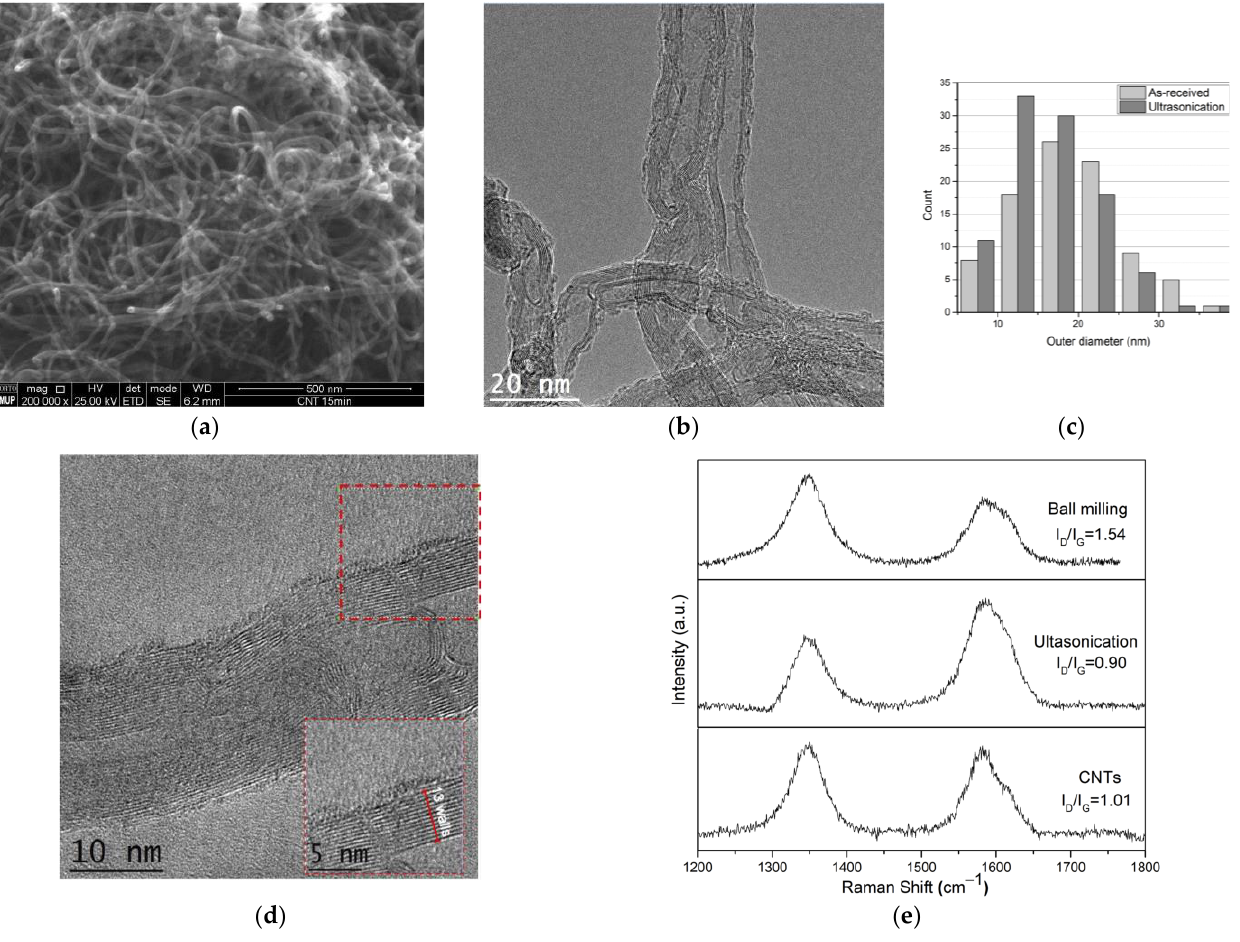
Figure 4. ( a ) SEM and ( b ) TEM images of ultrasonication CNTs, ( c ) distribution of outer diameter of the as-received and dispersed CNTs by ultrasonication, ( d ) HRTEM image of the CNT dispersed by ultrasonication showing in the region marked the magnification image the structure and the number of the walls, and ( e ) Raman results for the as-received CNTs and CNTs dispersed by ultrasonication and ball milling for 1 h.